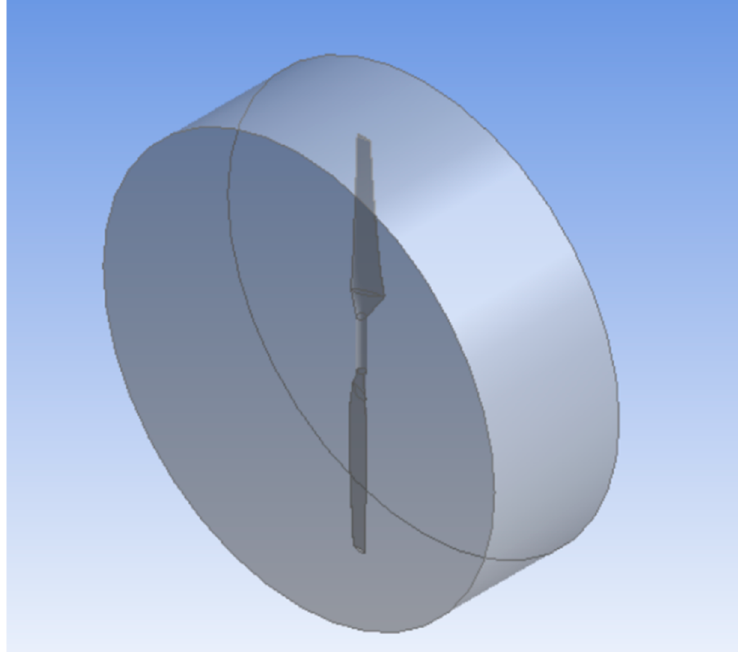
Figure 11. The rotating block.